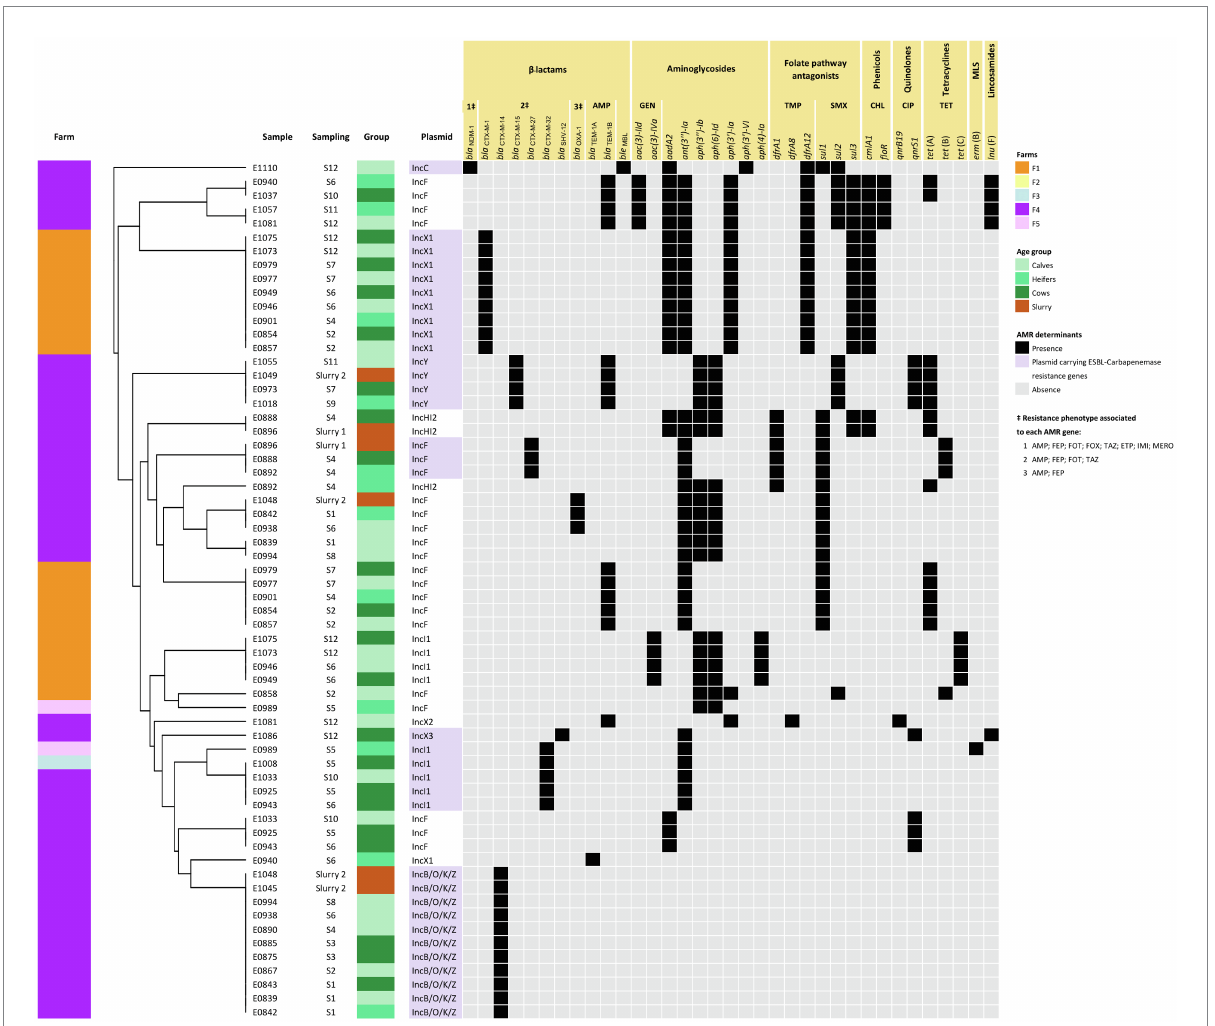
FIGURE 4 Heatmap showing ARG-harboring plasmids along with a dendrogram illustrating the similarity among plasmids based on their AMR pattern. Plasmids were grouped based on their antimicrobial resistance pattern (ARGs) according to the result of the hierarchical clustering using the average linkage method (UPGMA) on the Jaccard distance matrix. Further information including sampling and source (age group or slurry) is also